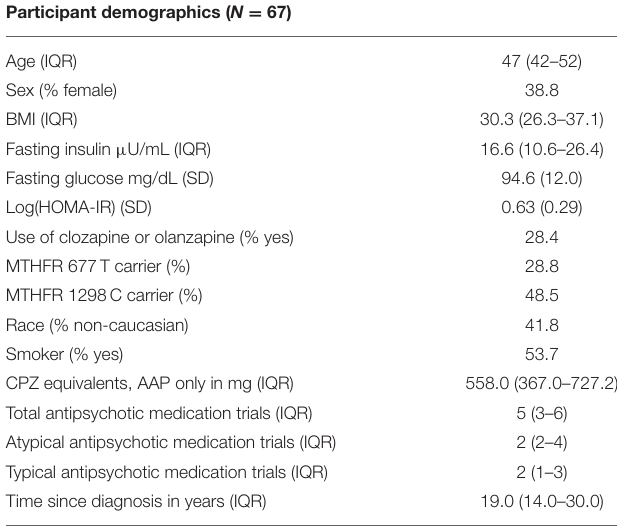
Table 3 . Results of the regression analysis including